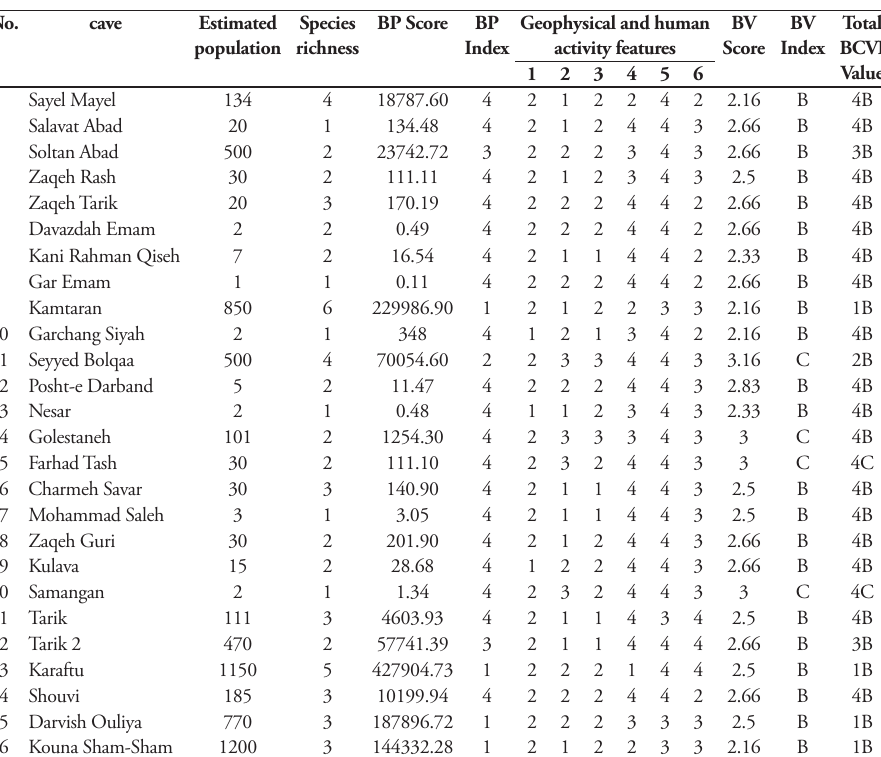
Table 5. BCVI values and total BCVI scores for Kurdistan caves. Geophysical and human activity fea- tures are classified as below: 1 – Accessibility to cave sites, 2 – Cave openings, 3 – Effort of exploration, 4 – Tourism Activity, 5 – Cave use, 6 – Land-use change activities within cave vicinity. Scores follow the methods in Tanaglo et al.